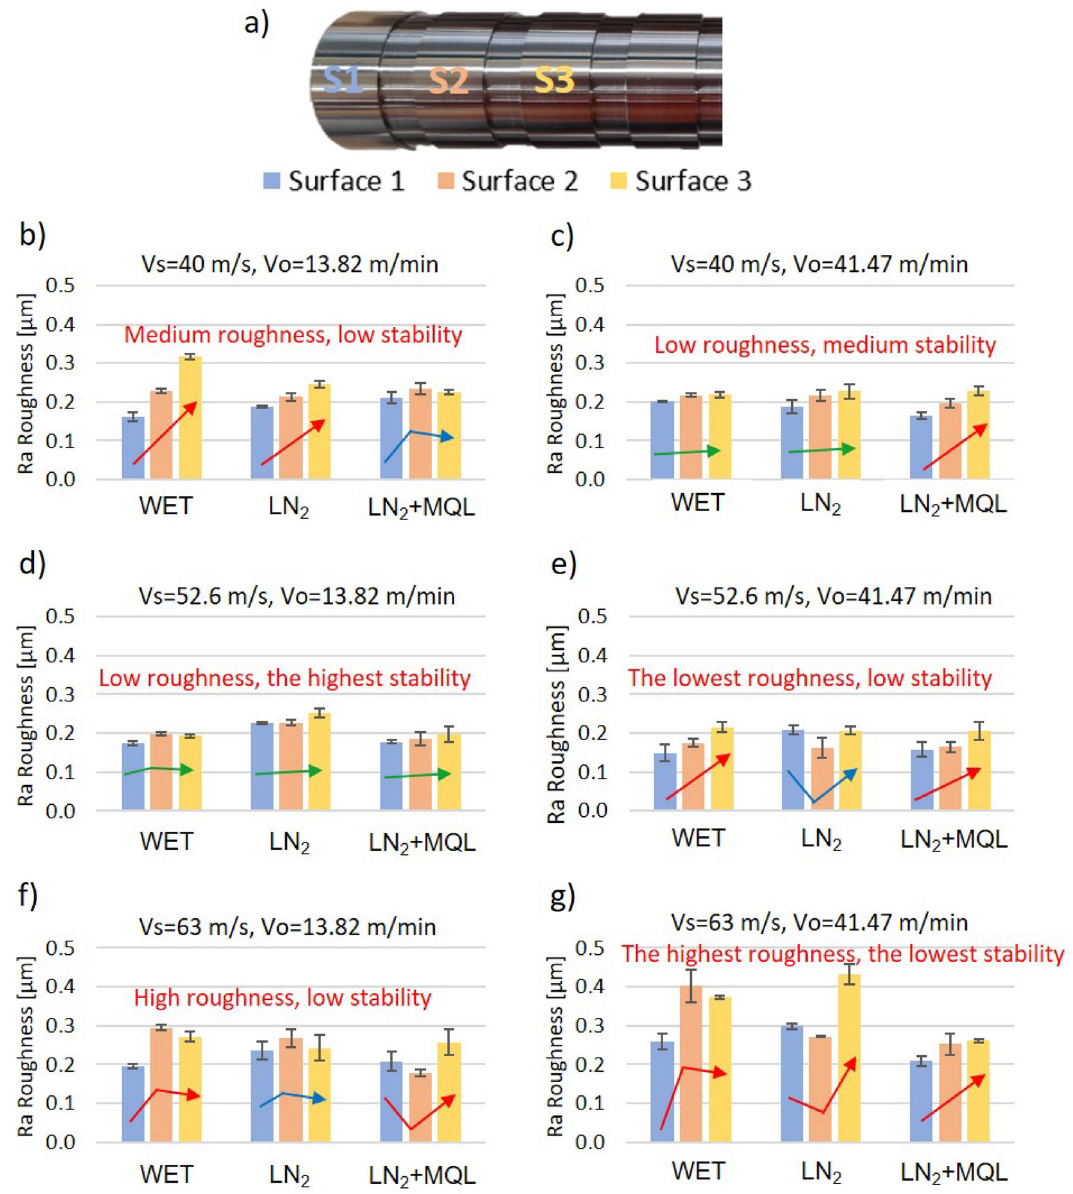
Figure 4. Surface roughness and process stability (identified by arrows) for three subsequent ground surfaces varying input